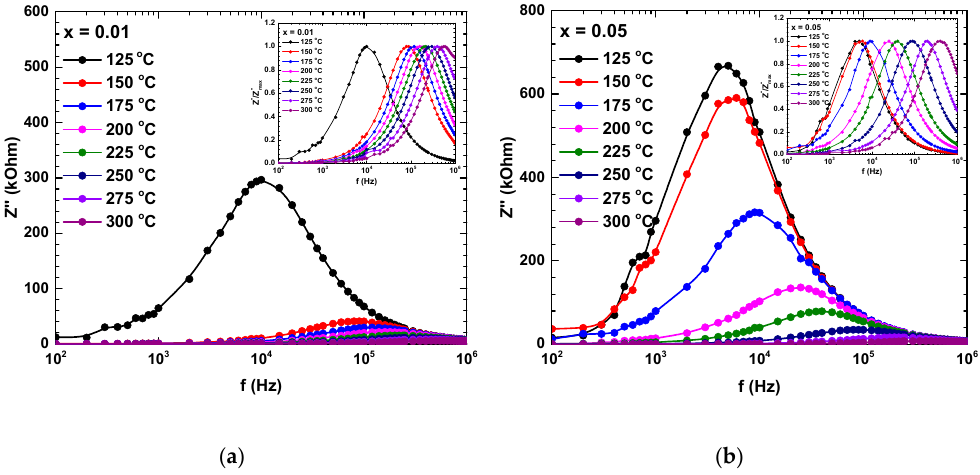
Figure 6. Bode plots for Z”(f) of LaFe 1 − x Zr x O 3 with ( a ) x = 0.01 and ( b ) x = 0.05 annealed at 800 ◦ C for 6 h at different temperatures.